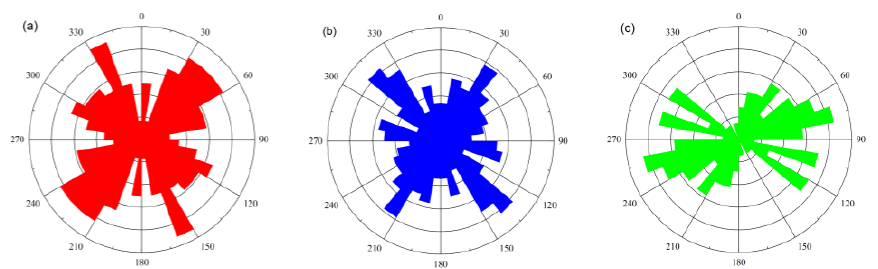
Figure 7. A rose diagram of the fracture strike of different tectonic units in the Luzhou area. ( a ) Fuji syncline; ( b ) Desheng – Baocang syncline; ( c ) Laisu – Yunjin syncline. syncline; ( b ) Desheng–Baocang syncline; ( c ) Laisu–Yunjin syncline. Transformational Shear Crack Transformational Shear Crack